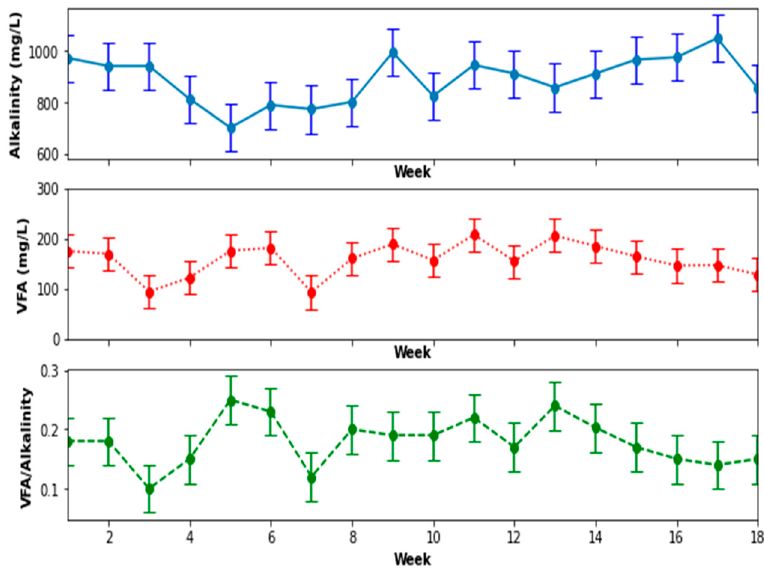
Figure 15. Variation of the VFA, Alkalinity and VFA/Alkalinity in the DEGBR.